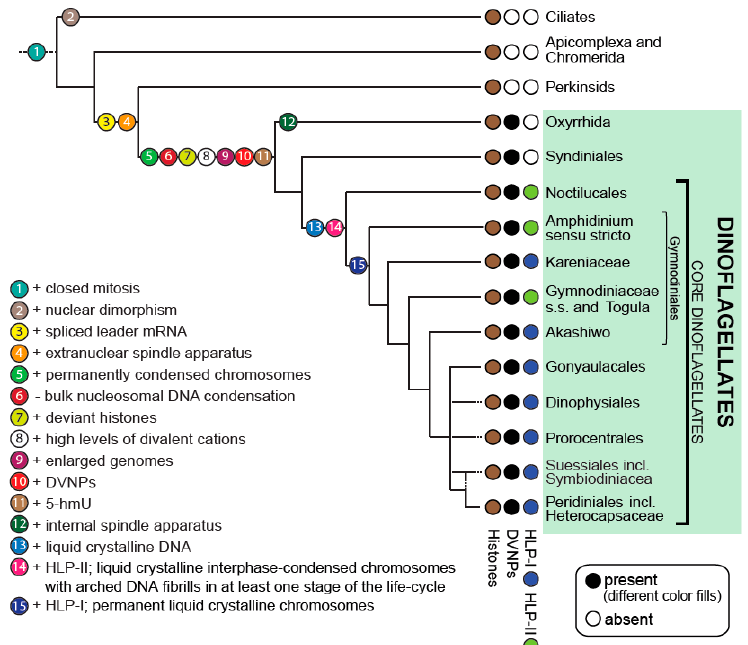
Figure 1. Nuclear character state evolution in dinoflagellates. Model depicting a consensus phylogeny of dinoflagellates and the progression of nuclear character state changes. Dotted branches indicate uncertain placements of taxa. Modified from Janouškovec et al. (2017) [2] and extended.